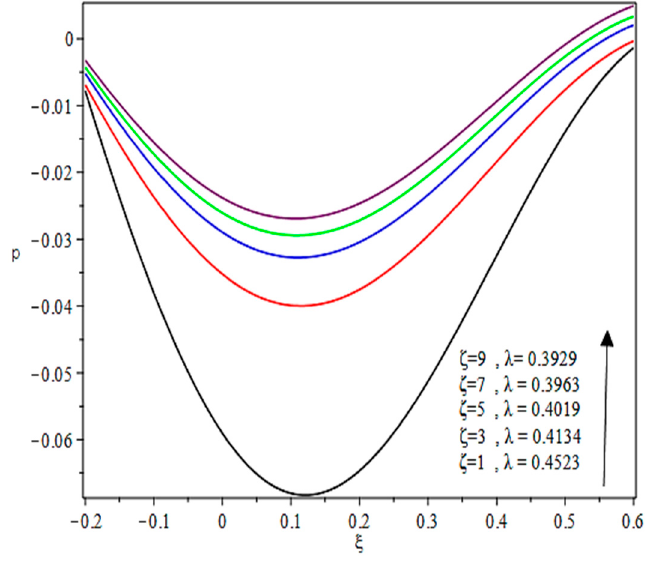
Figure 14. Influence of K on the pressure distribution by fixing ζ = 1, M = 0.2.